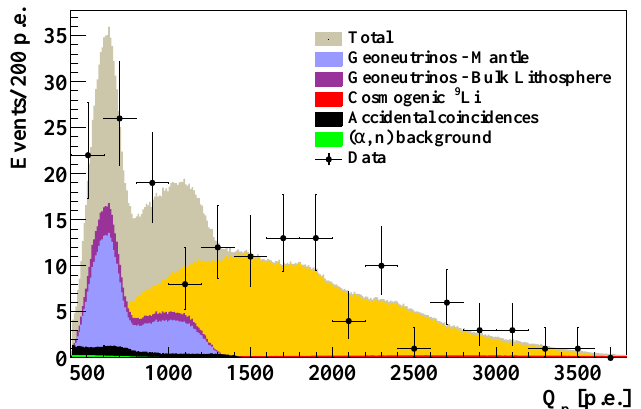
Figure 17. Spectral fit of the charge spectrum of prompt IBD candidates to extract the mantle signal after constraining the contribution of the bulk lithosphere. The gray shaded area shows the summed PDFs of all the signal and background components. From